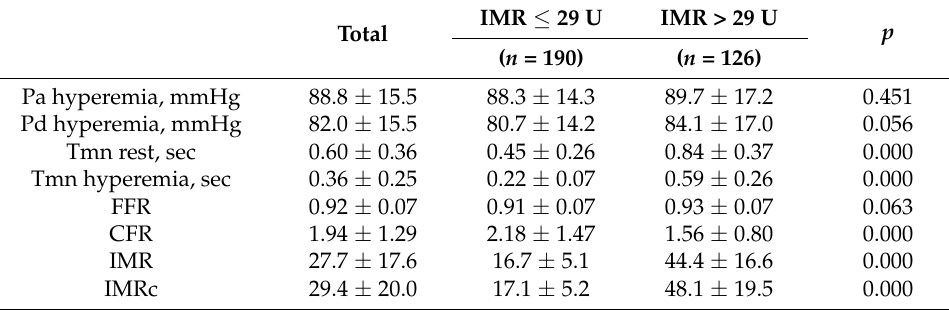
Table 2. Post-procedural coronary physiology